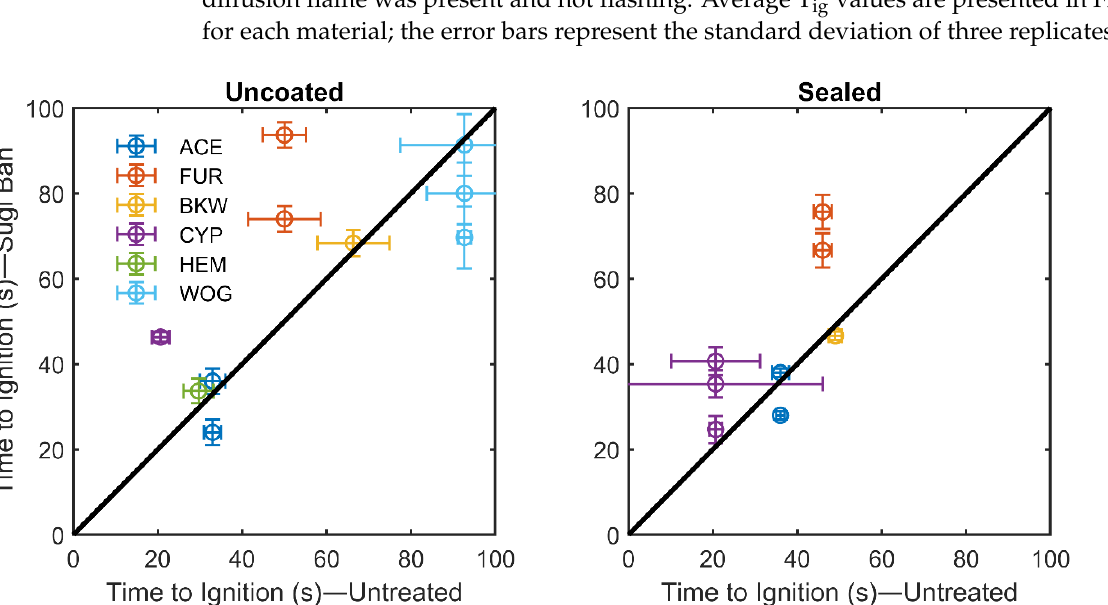
Figure 5. Comparison of the time to ignition (T ig , s) between the coated and uncoated specimens. The error bars represent the standard deviation. 3.2.2. Initial Peak Heat Release Rate Figure 6 plots the average pHRR i for the charred wood for each species against its uncharred counterpart; the error bars represent the standard deviation. For this metric, a lower value indicates a less flammable material or an improvement to the untreated case. Similar to the other metrics examined, the yakisugi process does not universally increase